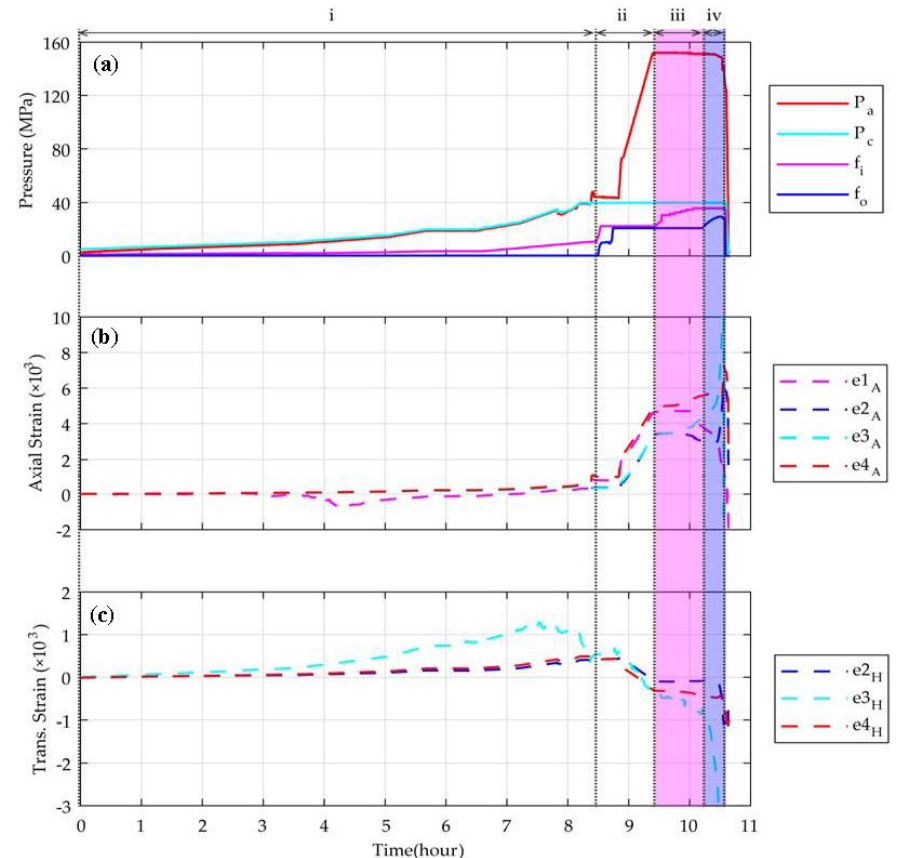
Figure 3. Stress loading and water injection processes for the sample, and the plots of strain curves. ( a ) numbers i–iv indicate loading and injection stages. P a and P c represent axial stress and confining pressure, respectively. f i and f o represent injection pressure from pump A and pump B, respectively; ( b ) axial strains monitored by sensor e1–e4; ( c ) circumferential strains monitored by sensors e2–e4, and the e1 H was broken or shorted before the test. (Figure 5 in [26]).